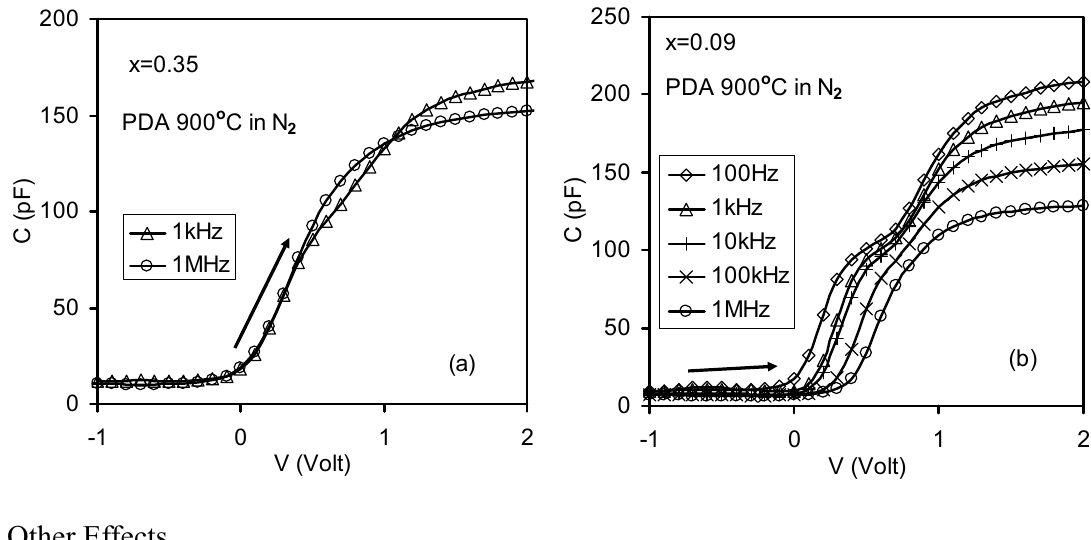
Figure 13. C-V results at different frequencies from the annealed La after back Al contact deposition and the effective substrate area was 6 cm 2 : ( a ) x = 0.35; and ( b ) x = 0.09. Signi fi cant frequency dispersion was observed for the x = 0.09 annealed sample, but not for the x = 0.35 annealed sample